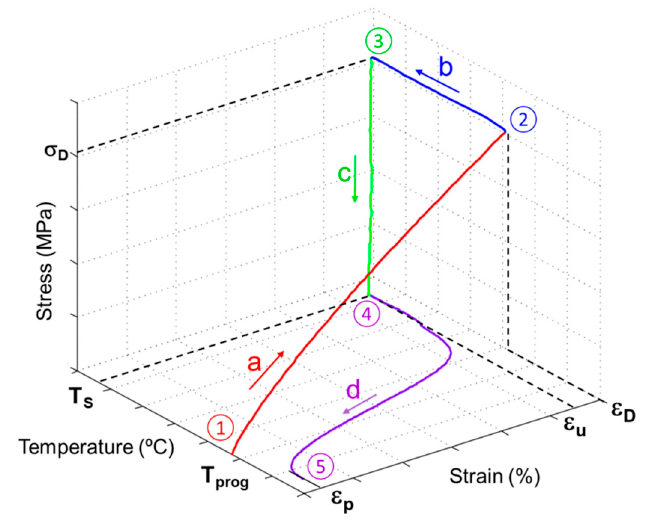
Figure 4. Thermo-responsive SMPs; 3D representation of the programing process.